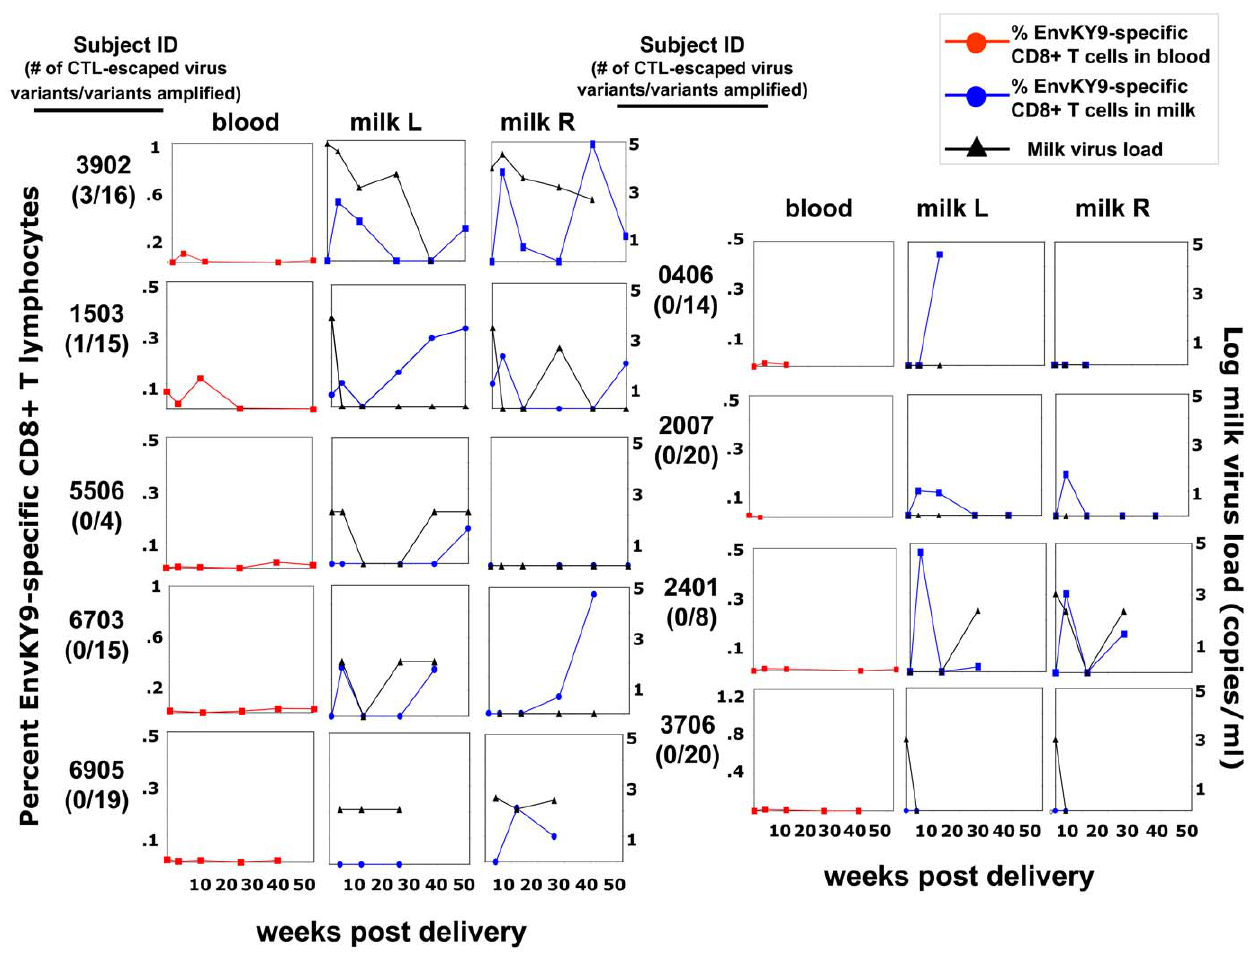
Figure 4. Variable relationship between the kinetics of the subdominant EnvKY9-specific CD8 + T cell response in milk (blue circles) and that in blood (red circles), as well as between the EnvKY9-specific CD8 + T cell response in milk and the breast milk virus RNA load (black triangles) in HIV-infected, lactating women. The plots of EnvKY9-specific CD8 + T lymphocyte responses and virus RNA load in blood (red circles) and milk of left and right breast (blue circles) from each subject are ordered by decreasing proportion of CTL-escaped plasma virus variants. Milk virus RNA load from each breast (black triangles) is plotted with the EnvKY9-specific CD8 + T lymphocyte responses in each breast.